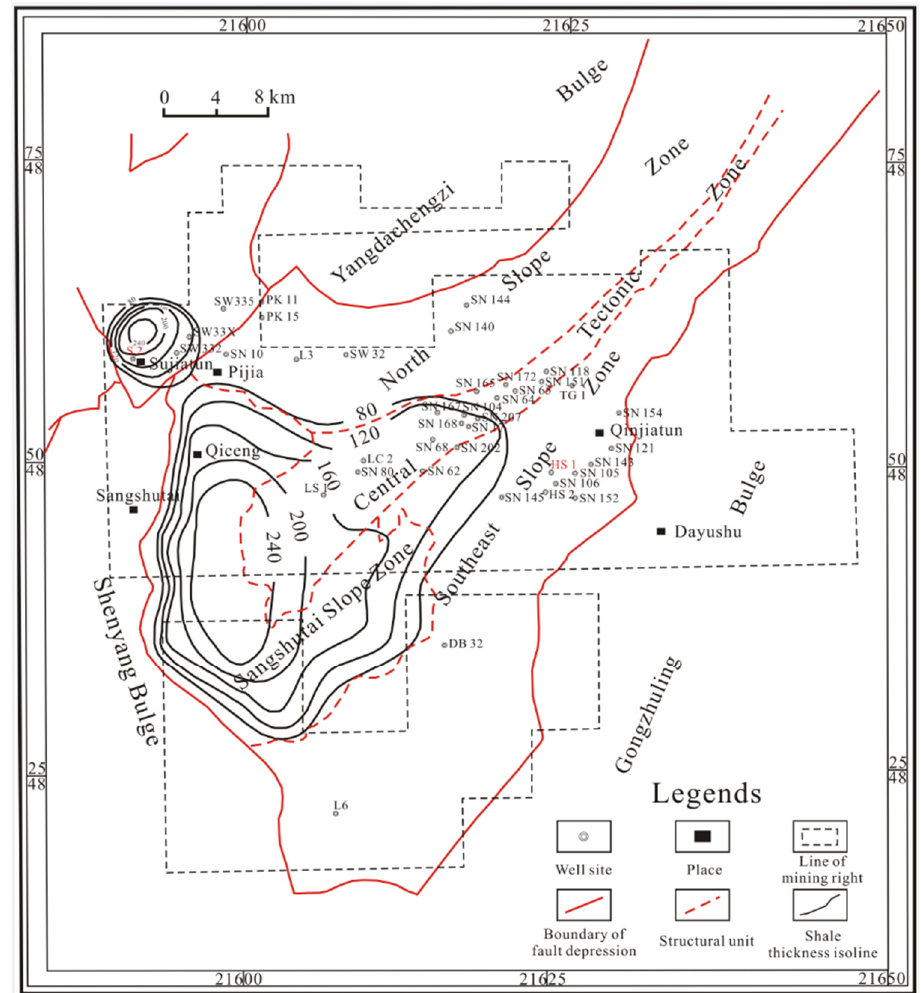
Figure 9. Contour map of shale thickness in the Yingcheng Formation.